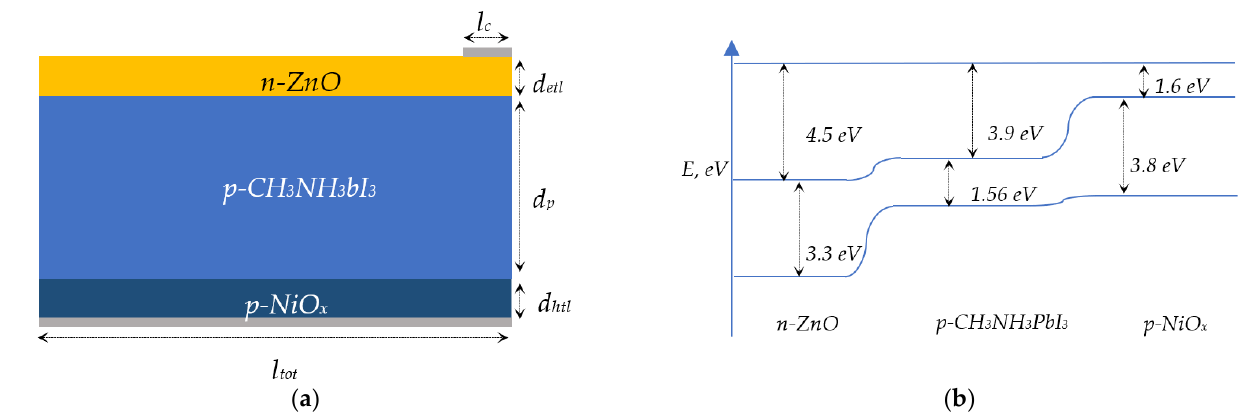
Figure 1. Geometric model ( a ) and band structure ( b ) of n-ZnO/p-CH 3 NH 3 PbI 3 /p-NiO x solar cell.